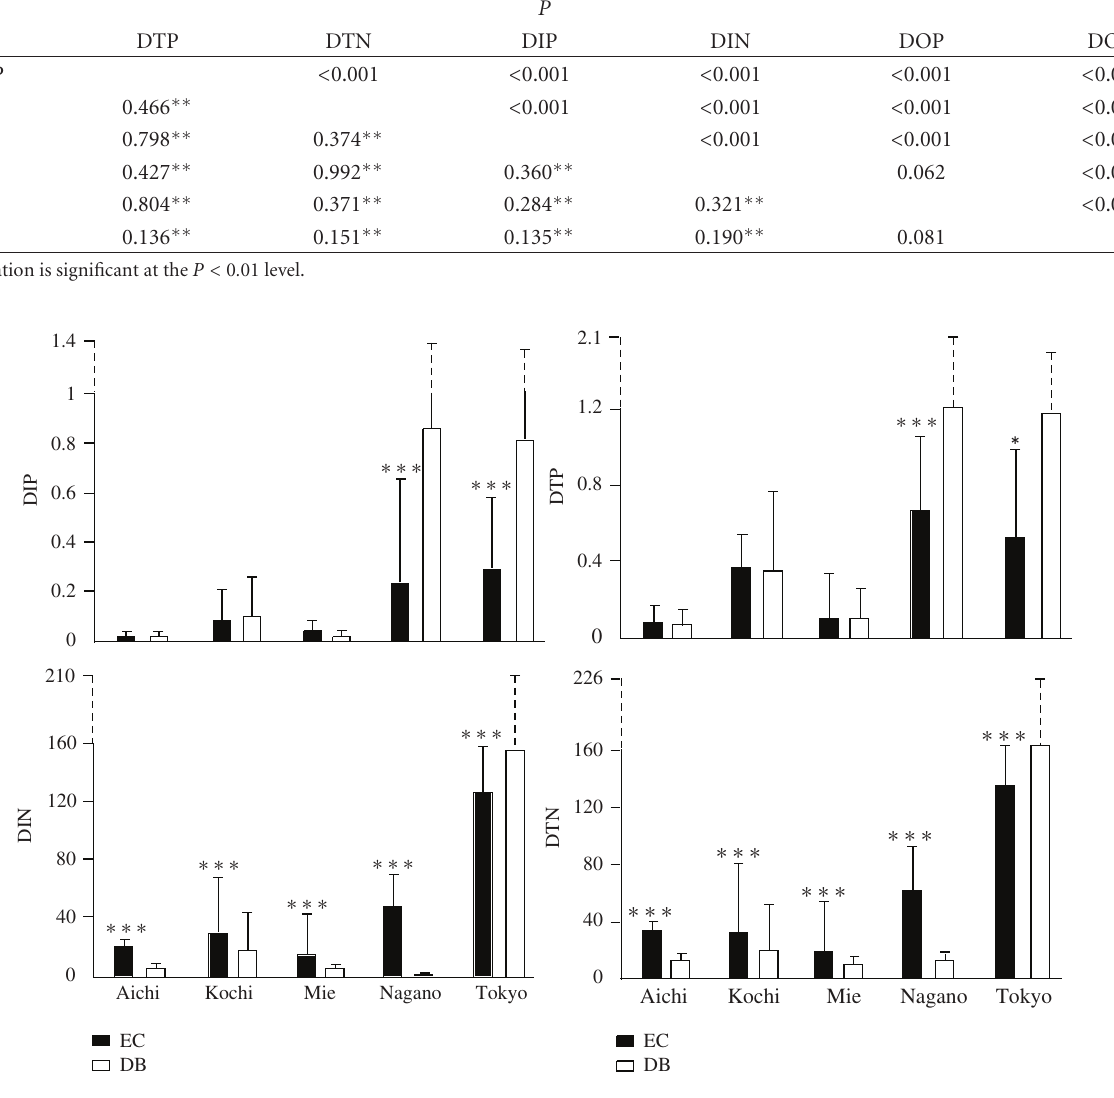
Figure 1: Forested stream nutrient concentrations for the di ff erent vegetation types in the five regions during storm events. The symbol on the top of columns shows a significant di ff erence at either ∗∗∗ P ≤ 0 . 001, ∗∗ 0 . 001 ≤ P ≤ 0 . 01, or ∗ 0 . 01 ≤ P ≤ 0 .